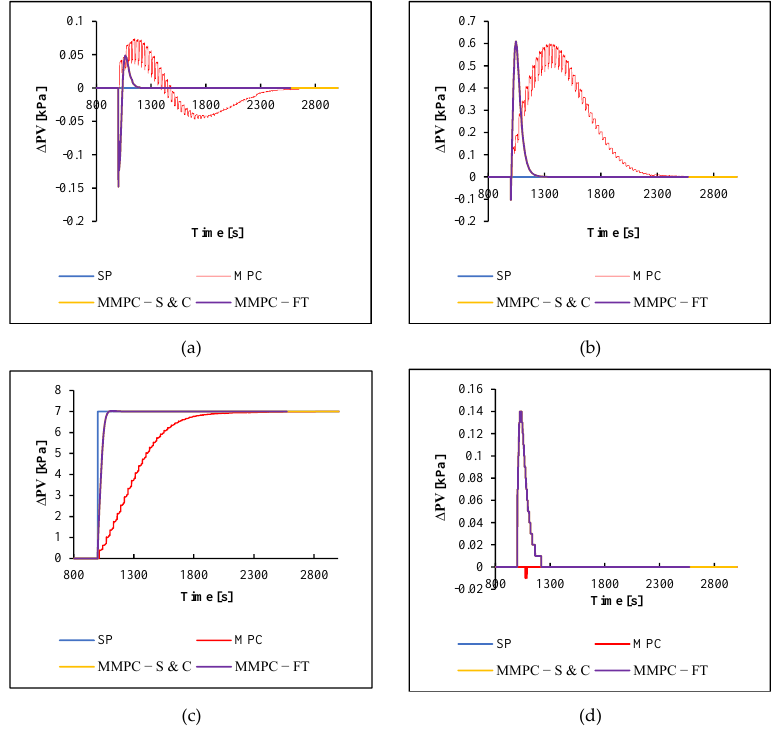
Figure 9. Comparison of controller performance with SP changes on compressor unit 3 (MIMO Model 2) on: ( a ) compressor unit 1; ( b ) compressor unit 2; ( c ) compressor unit 3; and ( d ) compressor unit 4.